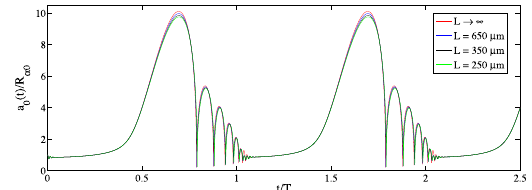
Figure 2. Temporal evolution of a 0 ( t ) at different distances between bubble centers ( L ) ( T = 50 l s, R a 0 = 4.5 l m).